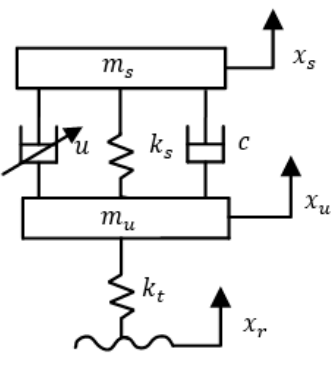
Figure 1. The 1/4 Semi-active Suspension Model.